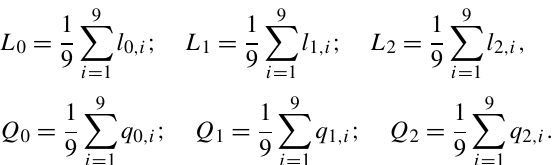
which is the slope of the black line at the origin in Fig.